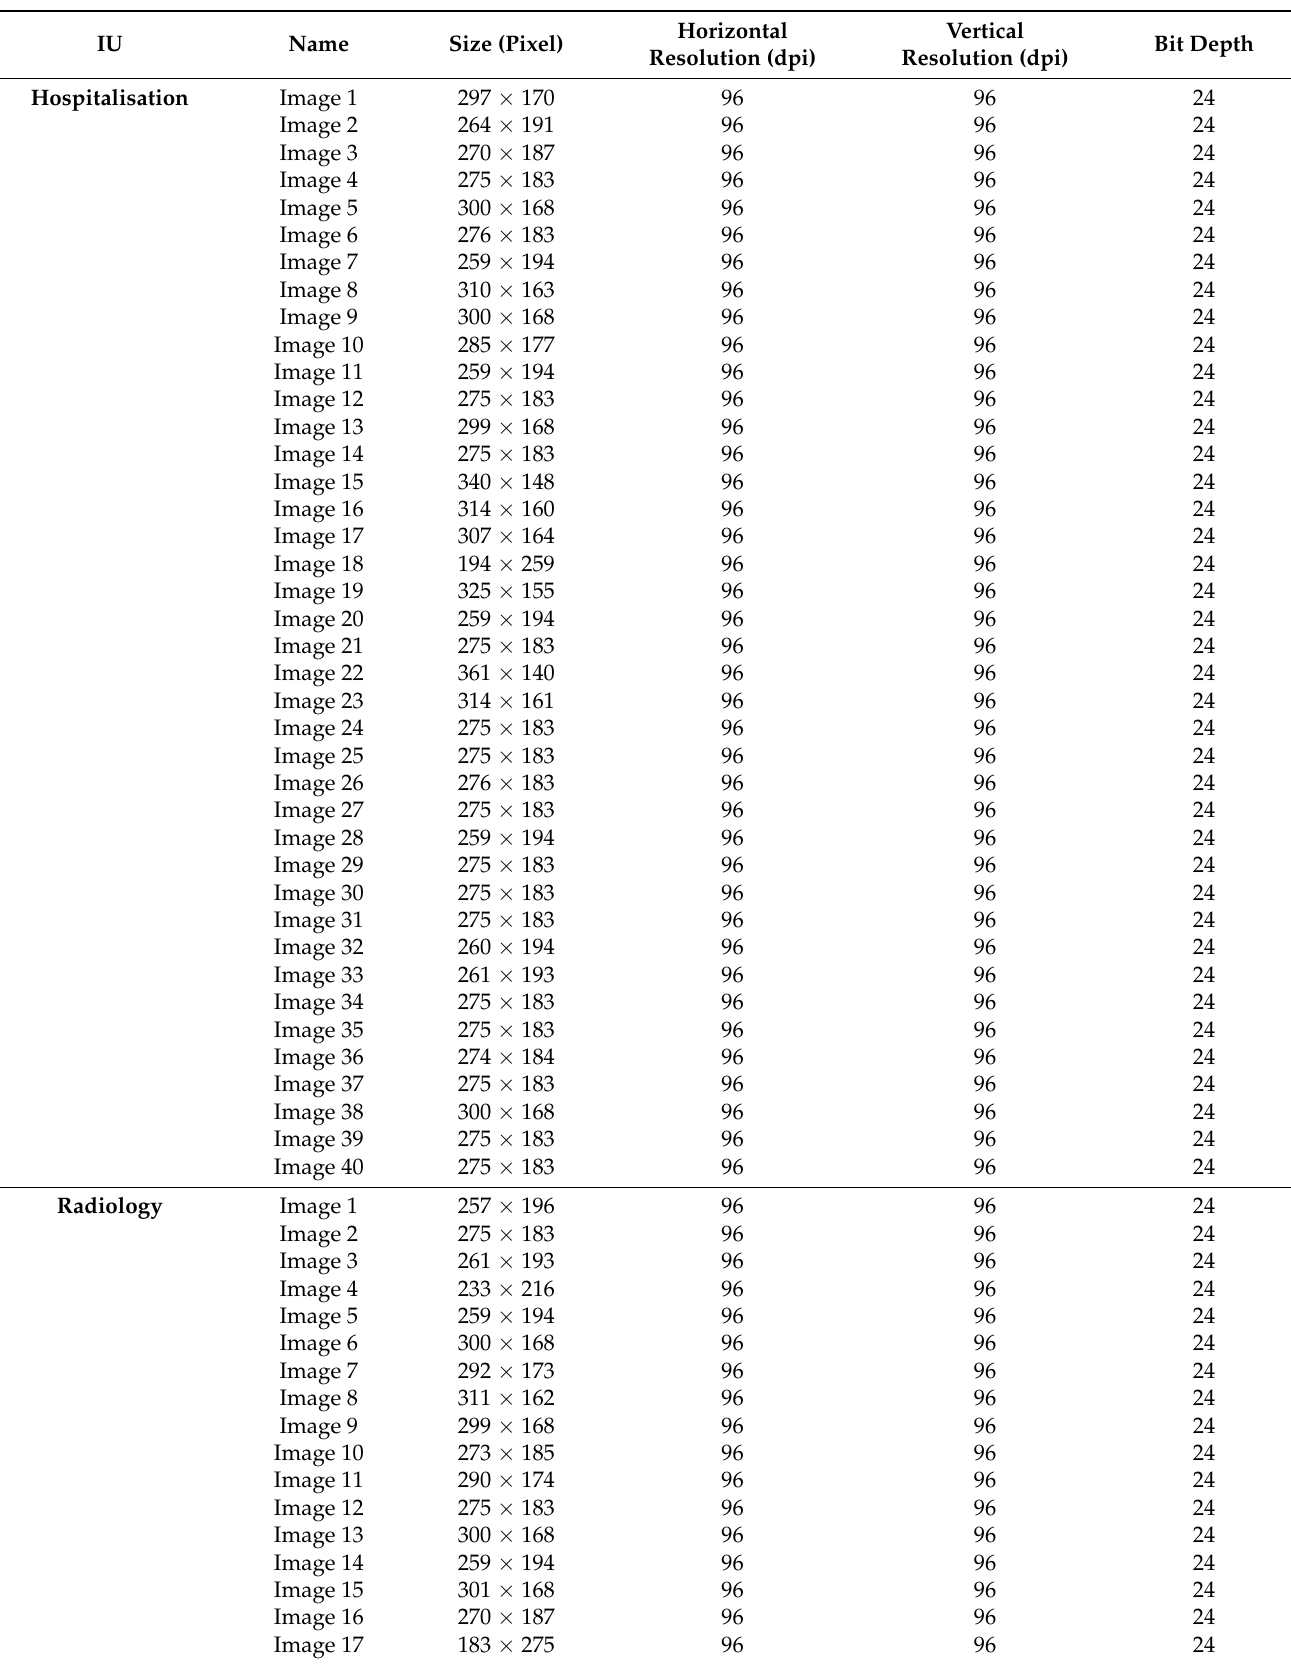
Table A7. Dataset used for the first version of the Detectron2 model (3